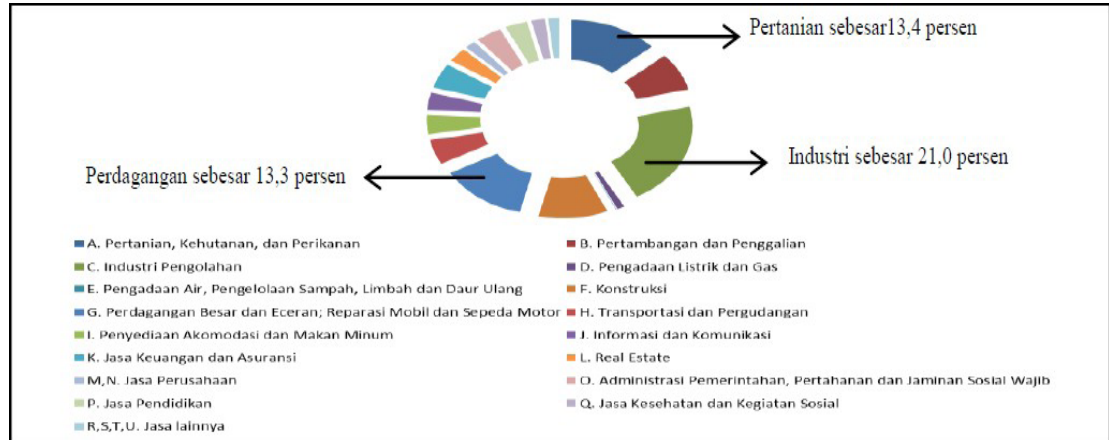
Figure 2(a): Sectoral Contribution by 2015 (in percent)